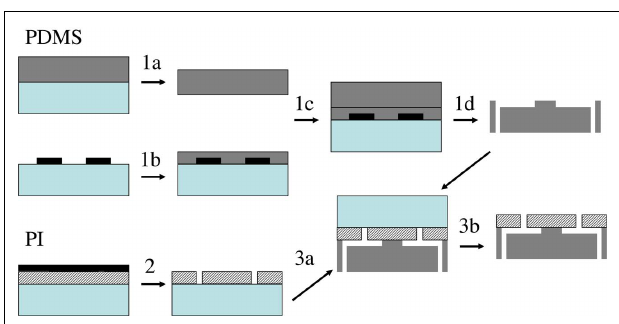
FIGURE 4 |Two-aperture transparent PI–PDMS chip. (A) Scanning electron micrograph showing the two apertures, each with a dedicated microfluidic channel for perfusion and measurement, seen through the transparent PI film in lighter gray.The channels are supported by many